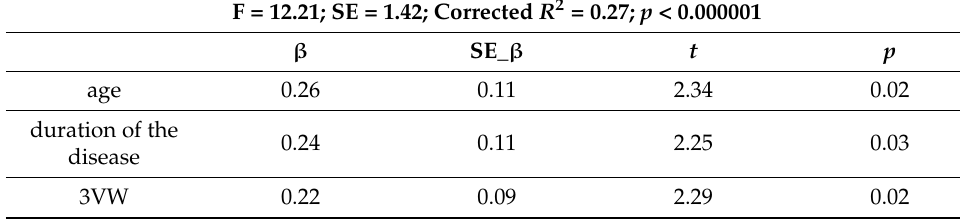
Table 4. Multiple regression model for